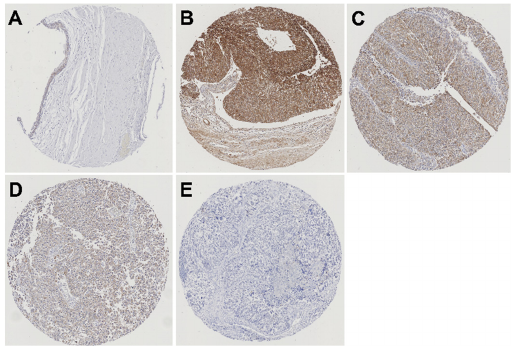
Figure 1. Typical patterns of immunohistochemical expression of Nectin-4 in UTUC tissue microarray specimens. ( A ) Normal urothelium with weak expression. ( B ) UTUC tissue with strong